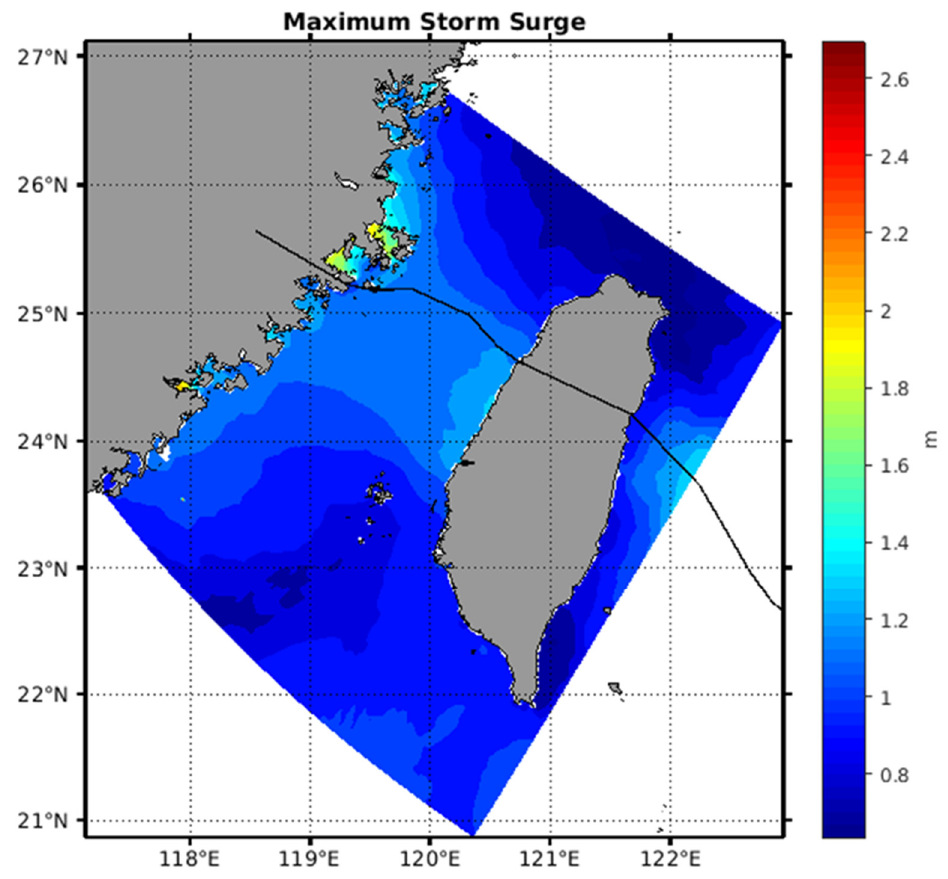
Figure 10. Spatial distribution of modelled maximum storm surge. Black line indicates track of Typhoon Nesat.